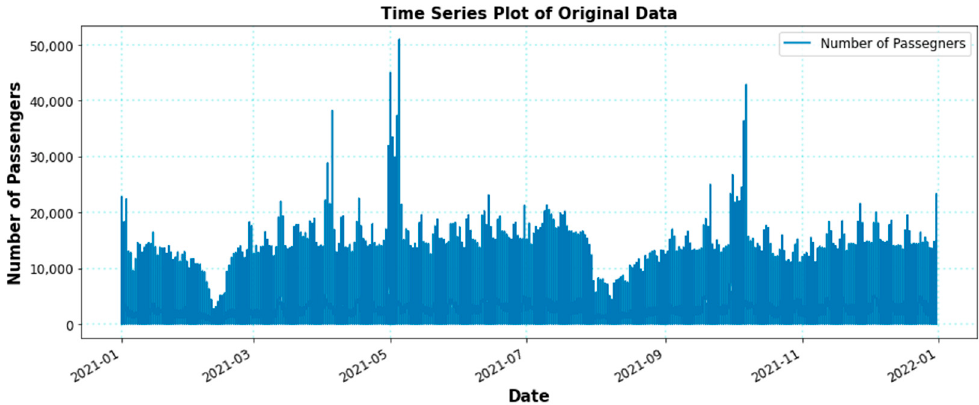
Figure 1. The original series’ plot.